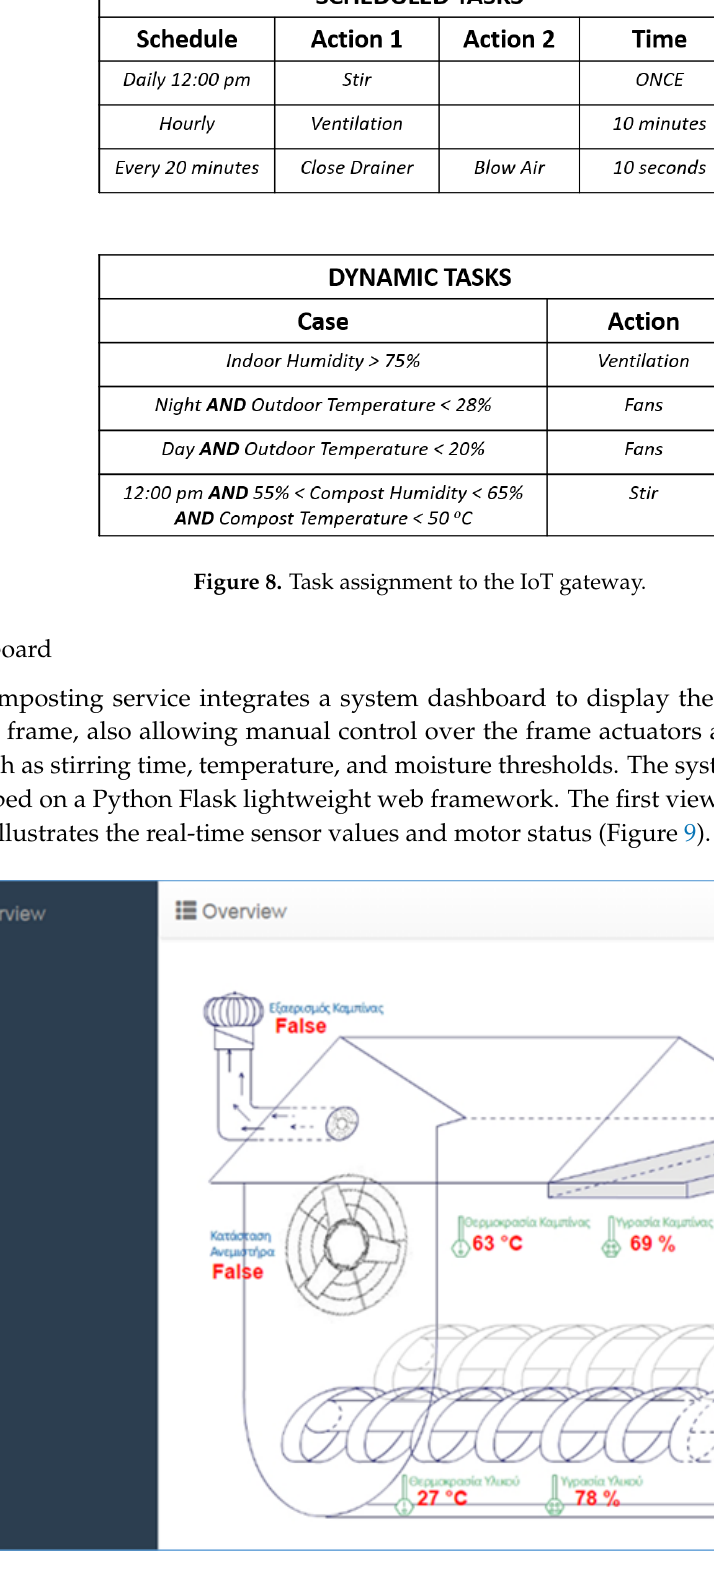
Figure 9. Dashboard